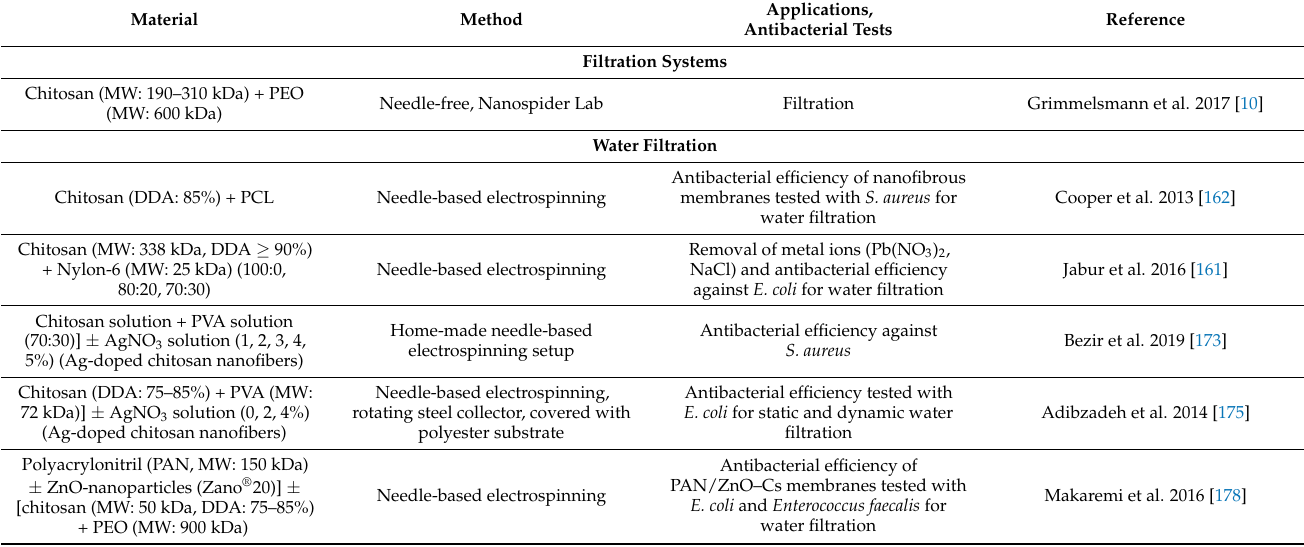
Table 2. Literature overview of electrospun chitosan composites used for different applications.